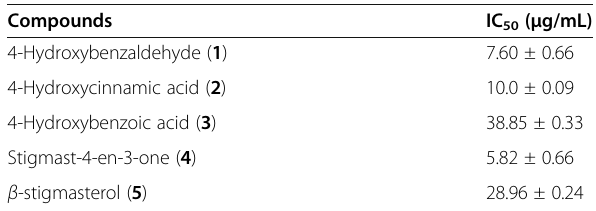
Table 3 IC 50 value of isolated pure compounds against Vero cell line